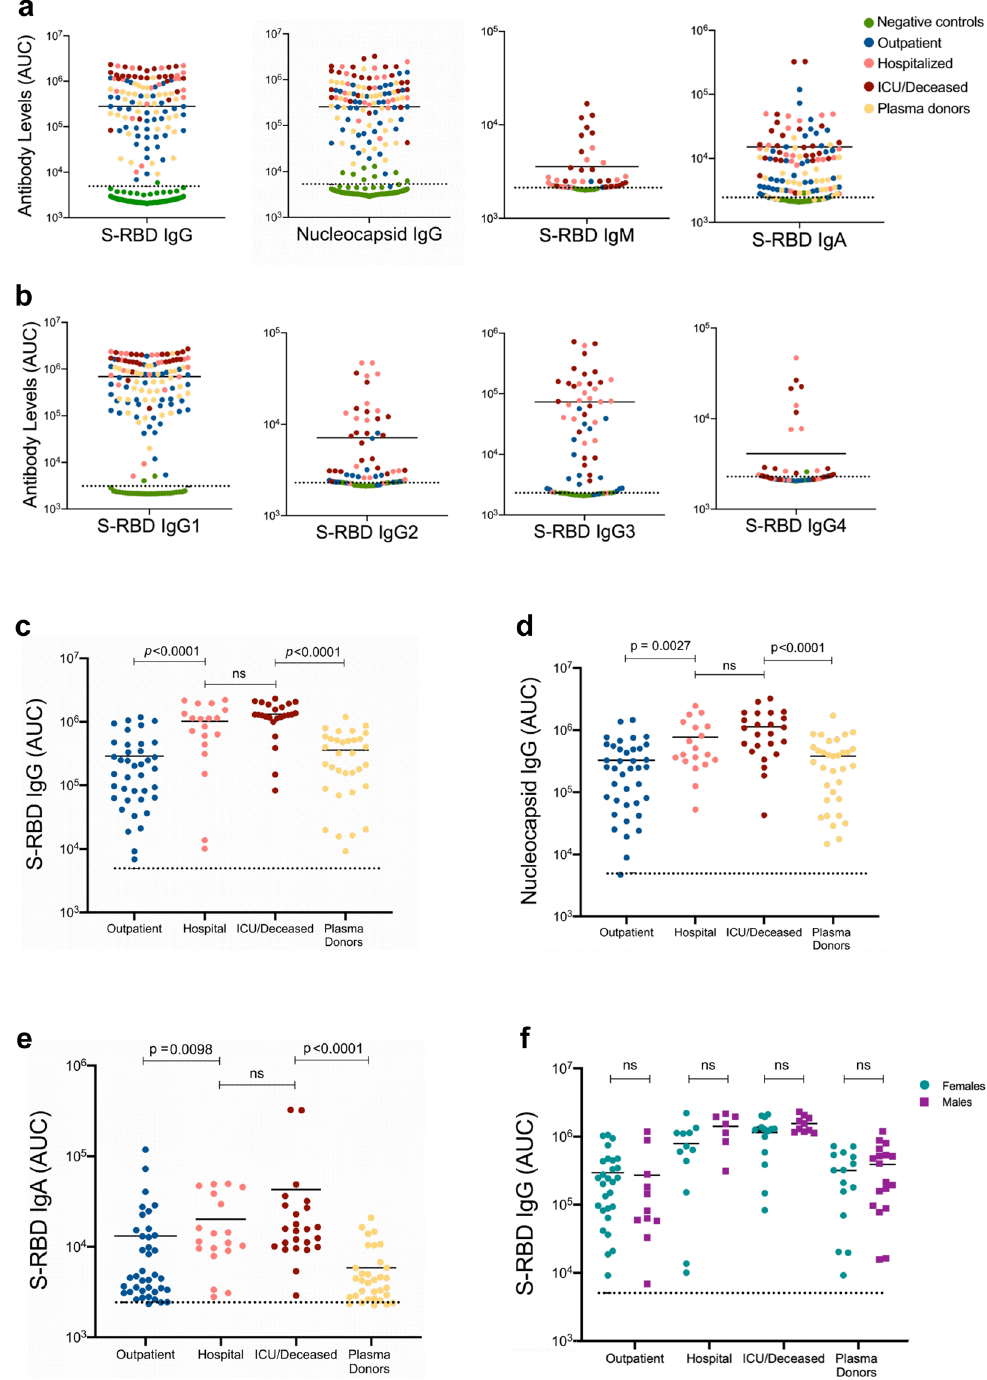
Fig. 2 SARS-CoV-2 speci fi c antibody detection in COVID-19 and convalescent plasma samples. a Measurement of spike protein and nucleocapsid protein-speci fi c IgG and spike protein-speci fi c IgM and IgA antibodies as described in Fig. 1. Area under the curve (AUC) values of plasma antibodies were calculated from reciprocal dilution curves in antibody detection assay ( n = 256 for S-RBD IgG and Nucleocapsid IgG, n = 50 for S-RBD IgM, n = 144 for S-RBD IgA). Dotted lines indicate the negative threshold calculated by adding 1 standard deviation to the mean AUC values of healthy controls ’ plasma. Horizontal bars show the mean value. Green, blue, salmon, red and yellow dots indicate negative controls, outpatient, hospitalized, ICU/deceased and plasma donor subjects, respectively. b S-RBD-speci fi c IgG subclass AUC levels ( n = 144 for S-RBD IgG1, n = 74 for S-RBD IgG2, S-RBD IgG3 and S-RBD IgG4) c S-RBD IgG AUC values of subject plasma grouped by outpatient, hospitalized, ICU or deceased and plasma donors ( n = 115) d Nucleocapsid protein IgG AUC values of subject plasma grouped by outpatient, hospitalized, ICU or deceased and convalescent plasma donors ( n = 115). e S-RBD IgA AUC values of subject plasma grouped by outpatient, hospitalized, ICU or deceased and plasma donors ( n = 115). f S-RBD IgG AUC values of severity groups and plasma donors subdivided into males and females ( n = 115). Green dots show female subjects while purple squares indicate male subjects. Statistical signi fi cances were determined using two-tailed Mann – Whitney U test.